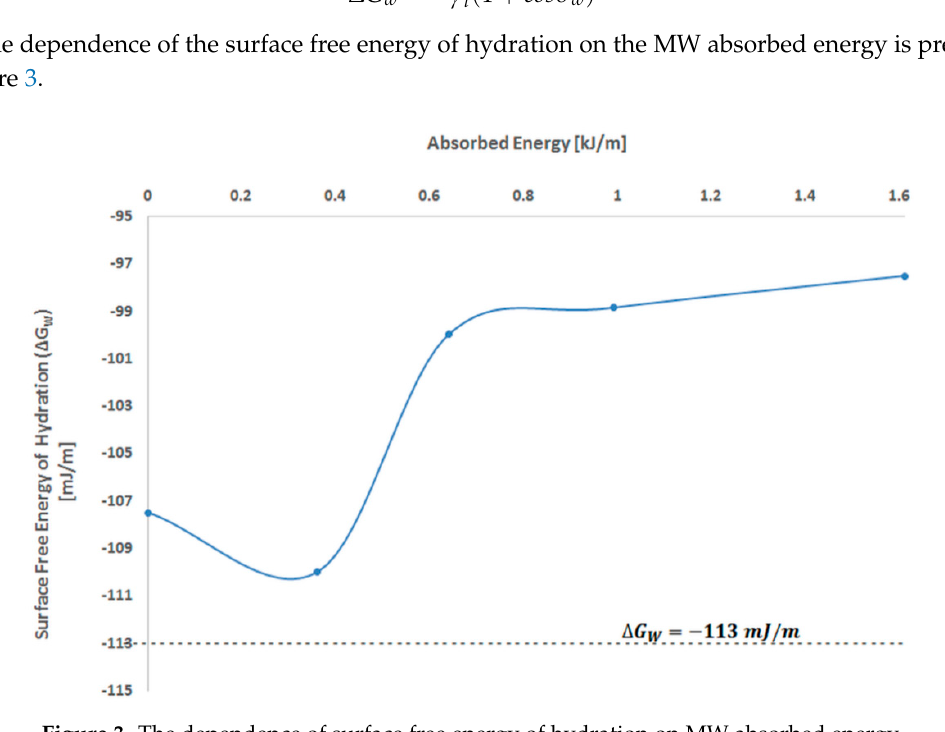
Figure 3. The dependence of surface free energy of hydration on MW absorbed energy.